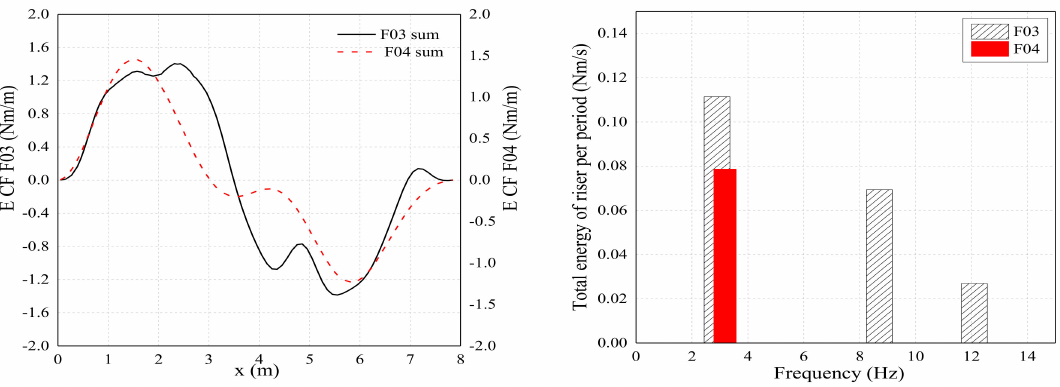
Figure 13. Distribution of vortex-shedding energy per unit period along pipe length and vibration frequency in CF direction of F03 and F04 under 1.6 m/s (E CF is the vortex-shedding energy per unit